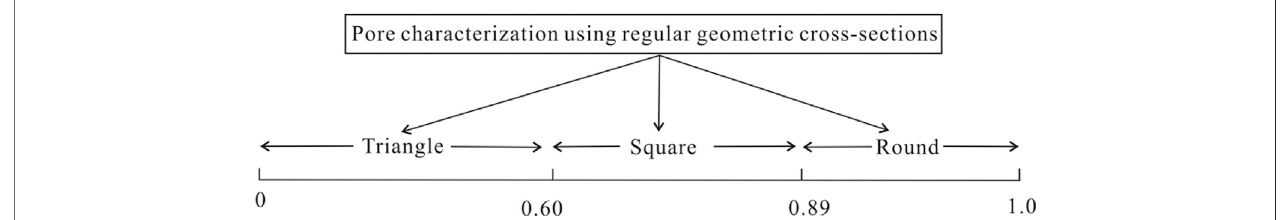
TABLE 1 | Composition and content of minerals in shale samples in the study area. No. Serial Depth number (m)